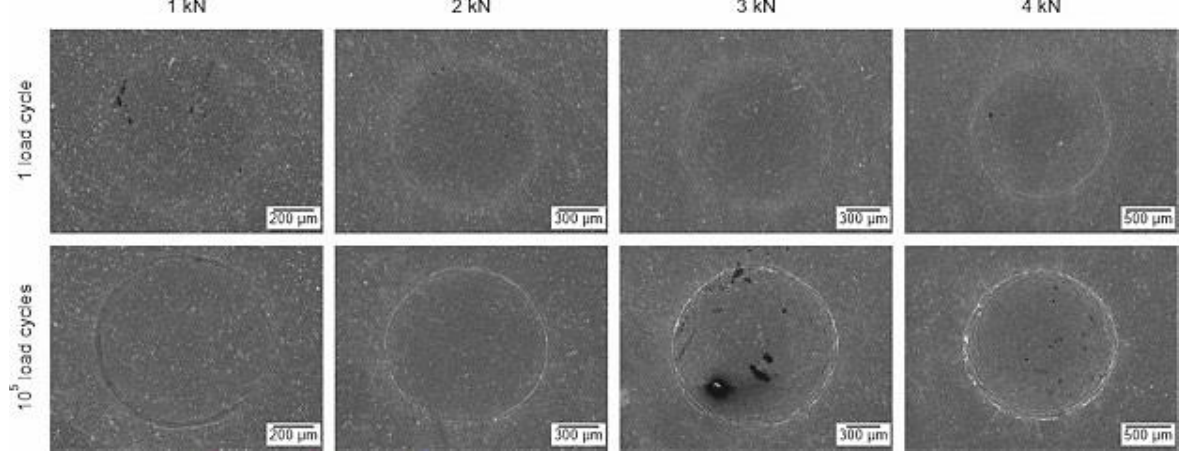
Figure 10. SEM images of the impacts for 1 to 4 kN and load cycles of 1 and 105 for the duplex treated St-B-C sample.